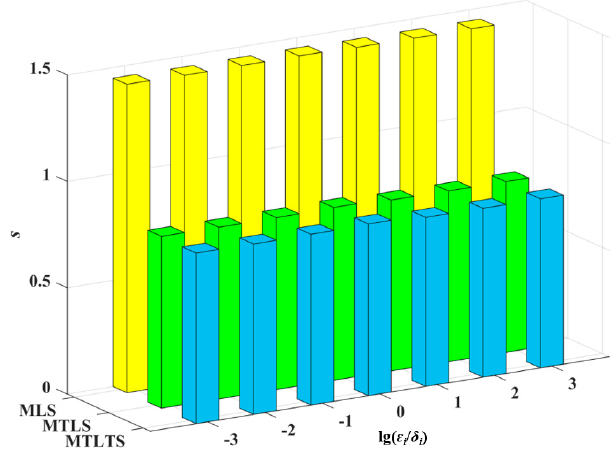
Figure 7. The trend of the s values.